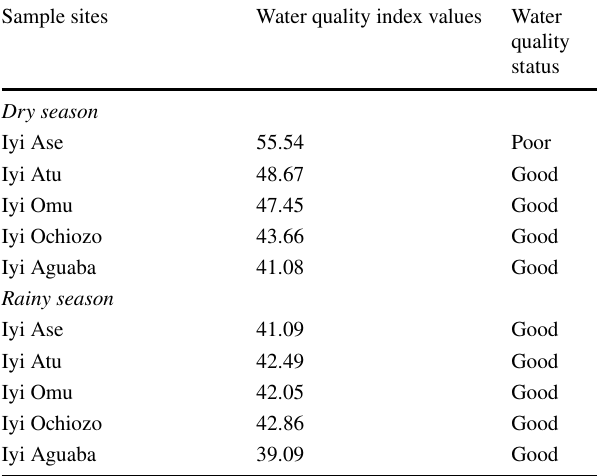
Table 5 The Water Quality Index and Water quality status of all the samples Sample